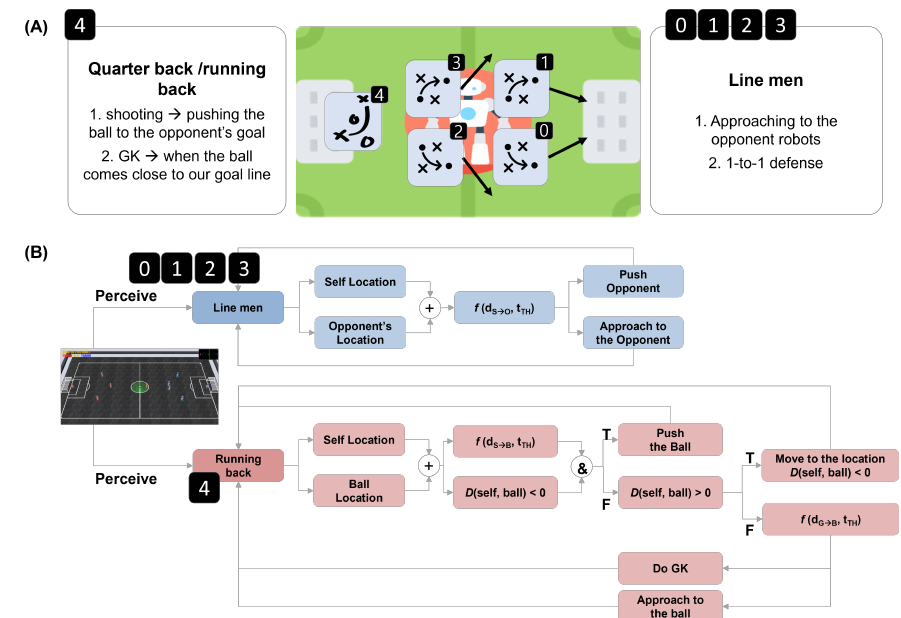
Figure 4. Engineering dynamic planning agents. ( A ) An illustration of an AI football strategy, called Gegenpressing , proposed in Yi et al. [35]. ( B ) Dynamic plans for Gegenpressing